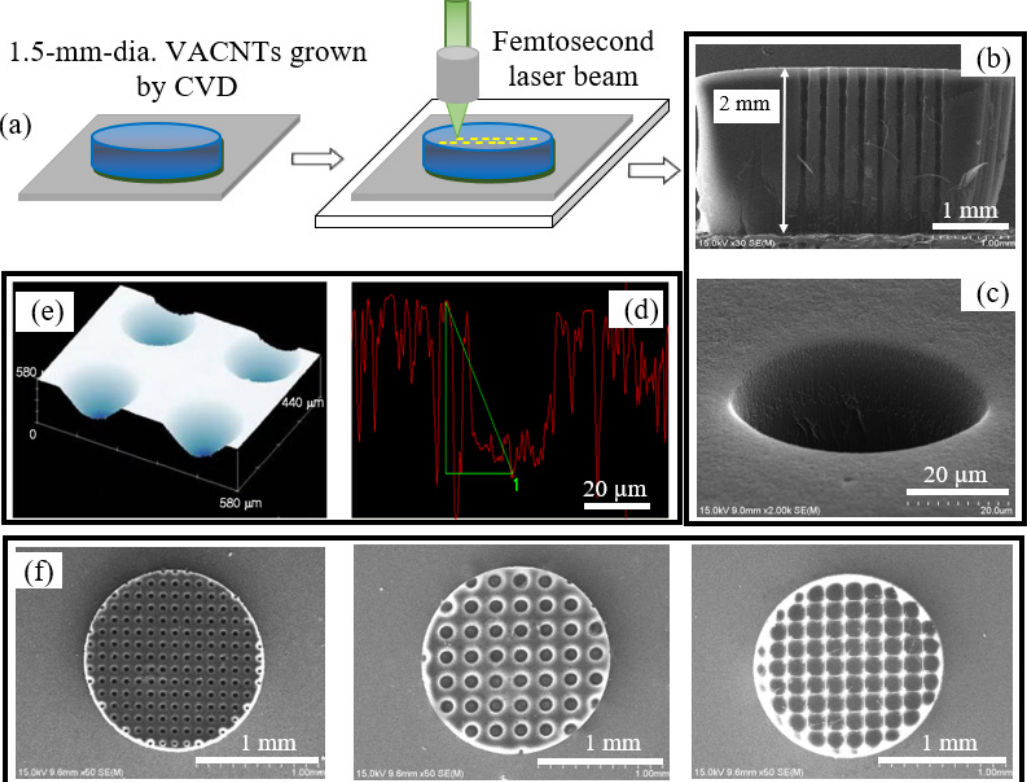
Figure 1. ( a ) Sketch of femtosecond laser process (repetition rate of 92 MHz, 80-fs pulse width, an average power of 200 mW); ( b , c ) SEM images of about 2-mm depth hollow cross-section (from the VACNT top to the bottom substrate and hollow shape on the top surface; ( d , e ) 3D confocal image and profile of the micro hollow with depth of ~200 µm, ( f ) typical micro-hollow arrays on 1.5 mm diameter, VACNT specimens, with depth of ~200 µm, and hollow diameters of 40, 100, and 150 µm, respectively (from left to right).